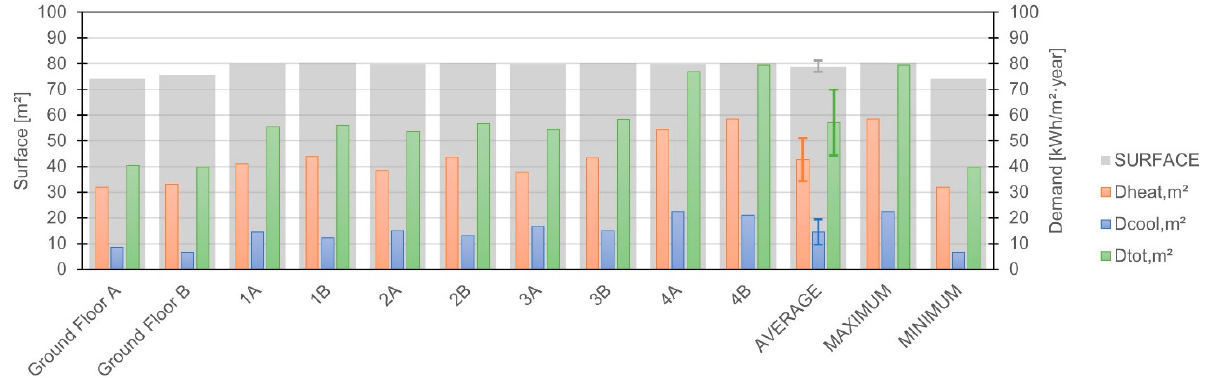
Figure 8. Annual average thermal demand values per m2 according to orientation.